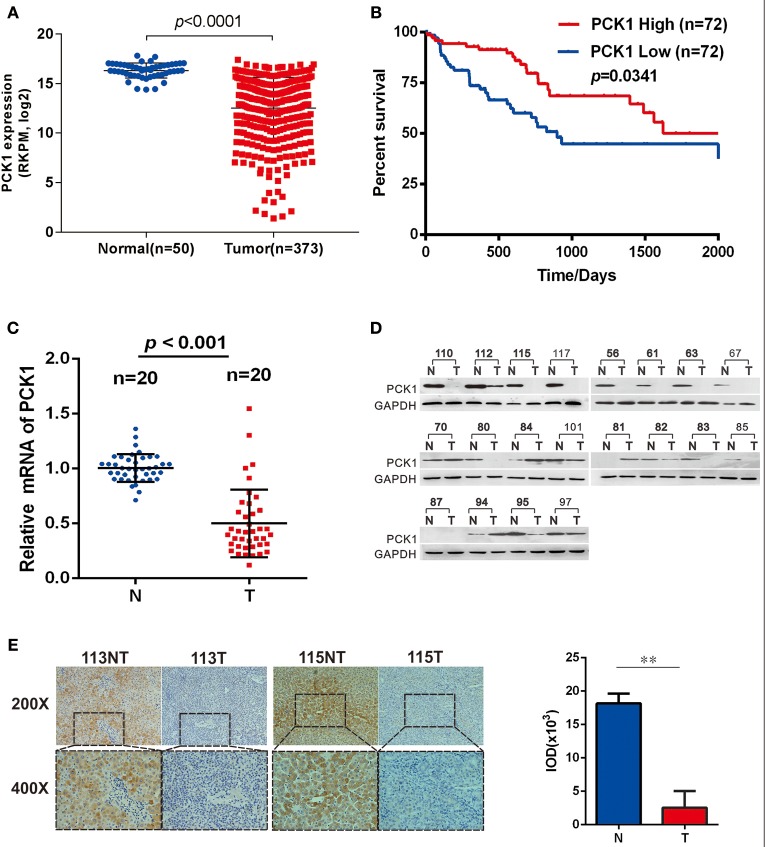
PCK1 is generally decreased in hepatocellular carcinoma (HCC) tissues and correlates with poorer patient prognosis. (A) Expression of PCK1 in patients with HCC in the TCGA Liver Hepatocellular Carcinoma (LIHC) dataset. (B) Kaplan Meier survival curve based on data for 142 HCC patients in the TCGA dataset, divided into two groups by PCK1 expression levels in tumors. N represents paratumor tissues. T represents tumor tissues. (C) RT-qPCR analysis of PCK1 expression in 20 paired HCC and adjacent non-tumorous tissues (P < 0.001). (D) PCK1 protein levels in 20 paired primary HCC tissues and adjacent non-tumor tissues determined by western blotting. β-actin was used as a loading control. (E) Representative immunohistochemistry (IHC) images of PCK1 in HCC and adjacent non-tumor tissues. Immunostaining intensity was measured using ImagePro Plus 6.0 software. (**P < 0.01); magnification: 400×, 200×. Statistical analysis of PCK1 protein levels from 4 pairs of HCC and adjacent non-tumor tissues as determined by IHC staining. The cropped blots are used in the figure and full length blots are presented in Figure S2.